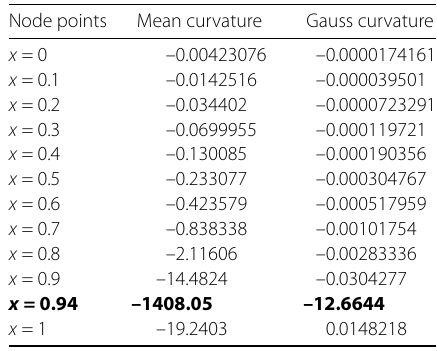
Table 3 Curvatures of r ( x , t ) surface at node points Node points Mean